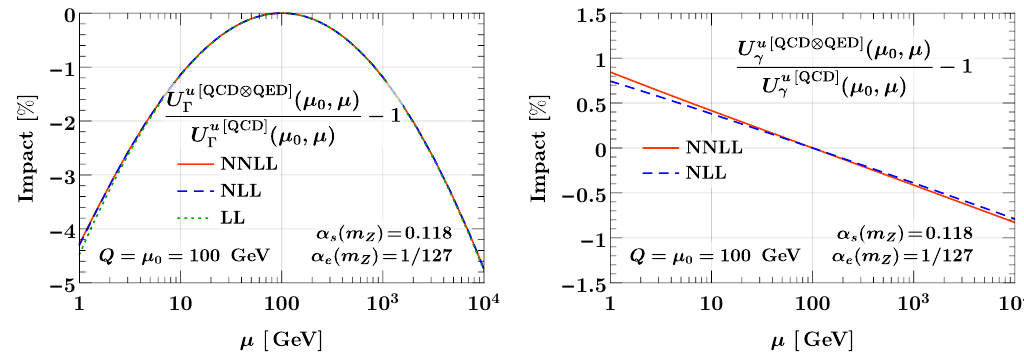
Figure 11 . Impact of the QED corrections on the u -quark Sudakov evolution kernel at LL, NLL, and NNLL for the cusp (left panel) and noncusp (right panel) contributions. We show the relative di(cid:11)erence of the full QCD (cid:10) QED evolution to the pure QCD case at the corresponding order.